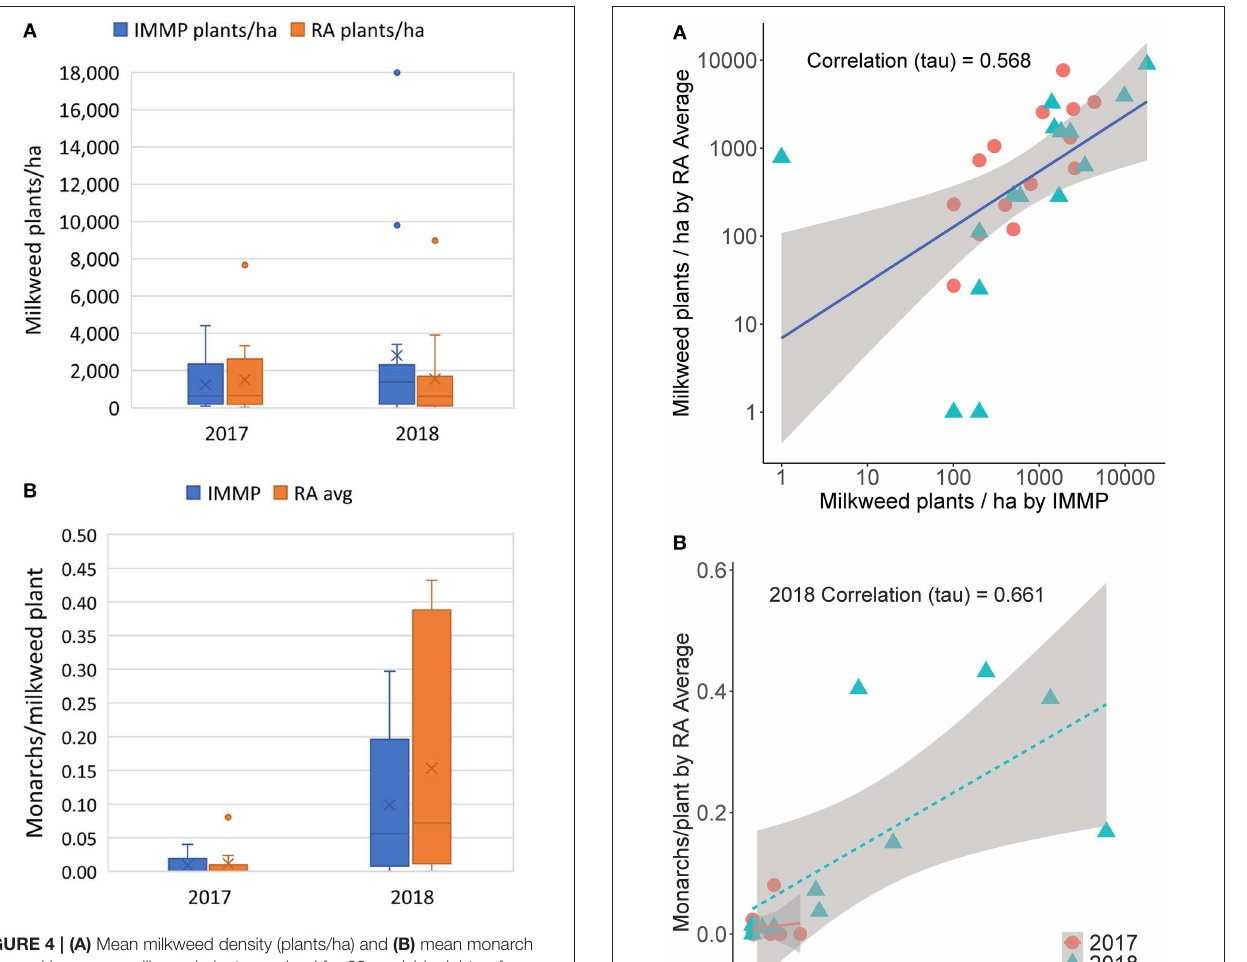
FIGURE 4 | (A) Mean milkweed density (plants/ha) and (B) mean monarch eggs and larvae per milkweed plant examined for 29 roadside rights-of-way sites in Minnesota sampled in 2017 and 2018, comparing years and two sampling methodologies, the Integrated Monarch Monitoring Program (IMMP) and averaged values for 2–4 Roadside Habitat for Monarchs Rapid Assessment (RA) taken from the same sampling location. Milkweed density did not vary by protocol type ( t 83 = − 0.639; p = 0.524, df = 83) or by year ( t 27 = 0.415, p = 0.681). Monarchs/plant did not differ by protocol type ( t 66 = 0.118; p = 0.906) but year was a significant factor ( t 27 = 2.373, p = 0.025). Mean values are indicated by the “x”; median values by a horizontal line, boxes indicate 25 and 75% quartiles, bars indicate the upper and lower quartiles, and outliers more than 1.5 the 75% quartile are depicted by dots.